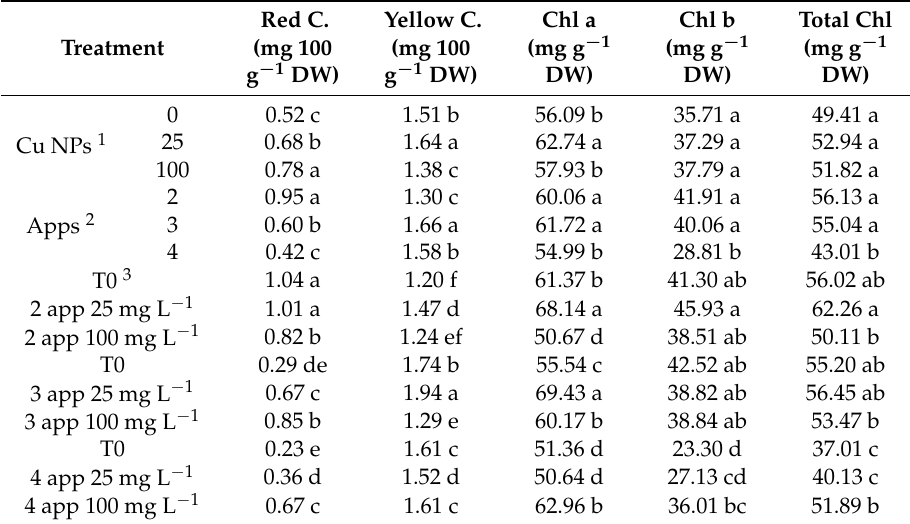
Table 2. Content of carotenoids and chlorophyll in the leaves of Moringa oleifera . Red Treatment